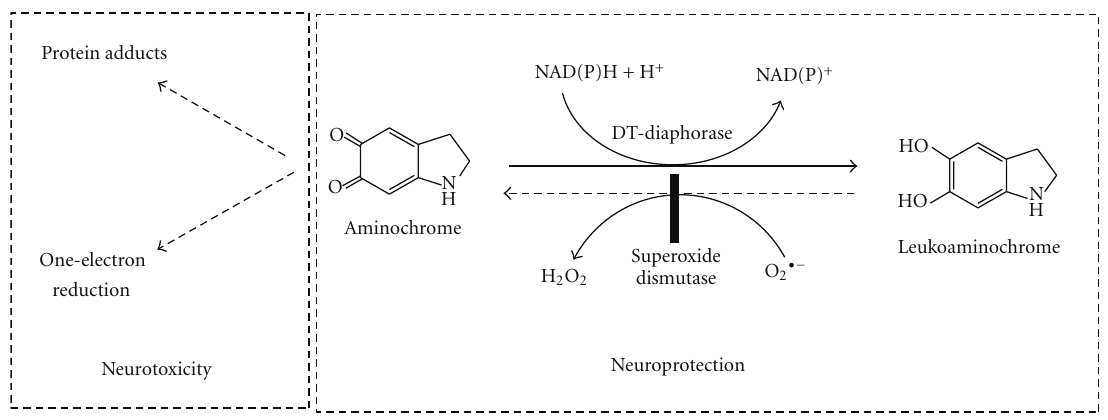
Figure 7: Two-electron reduction of aminochrome catalyzed by DT-diaphorase. DT-diaphorase prevents the participation of aminochrome in neurotoxic reactions, such as the formation of adducts with proteins and one-electron reduction of aminochrome to leukoaminochrome.